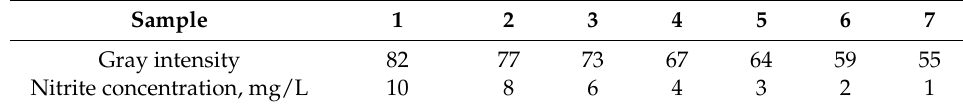
Figure 10. Colorimetric assay of nitrite via color-reaction by using microfluidic analytical device: ( a ) Image of the testing microfluidic analytical device; ( b ) Curve for nitrite ion. Table 3. Nitrite concentration of samples 1–7 and their corresponding gray